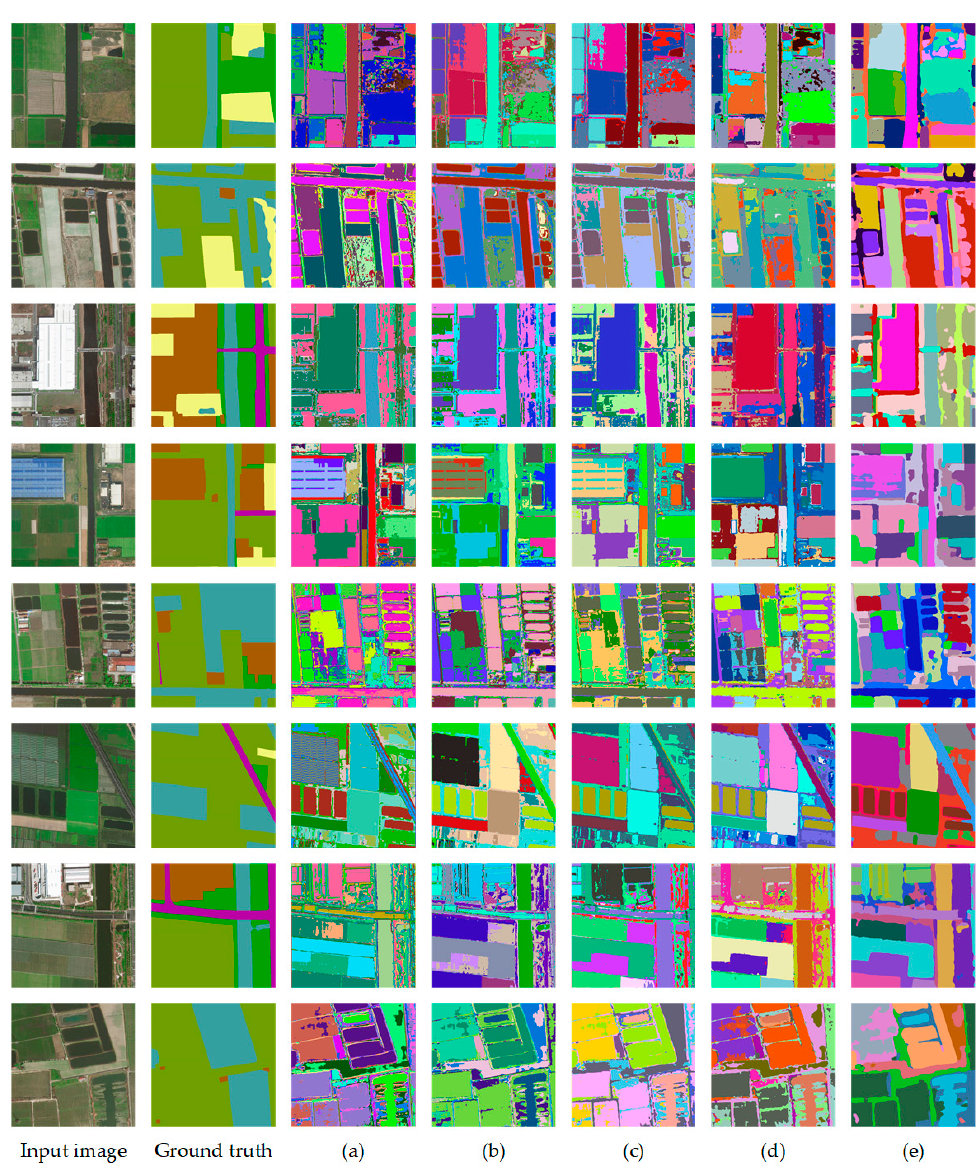
Figure 7. Representative examples of unsupervised remote sensing image segmentation results on Zhejiang dataset: ( a ) gPb, ( b ) UCM, ( c ) BackProp, ( d ) DFC, ( e ) our CCT.